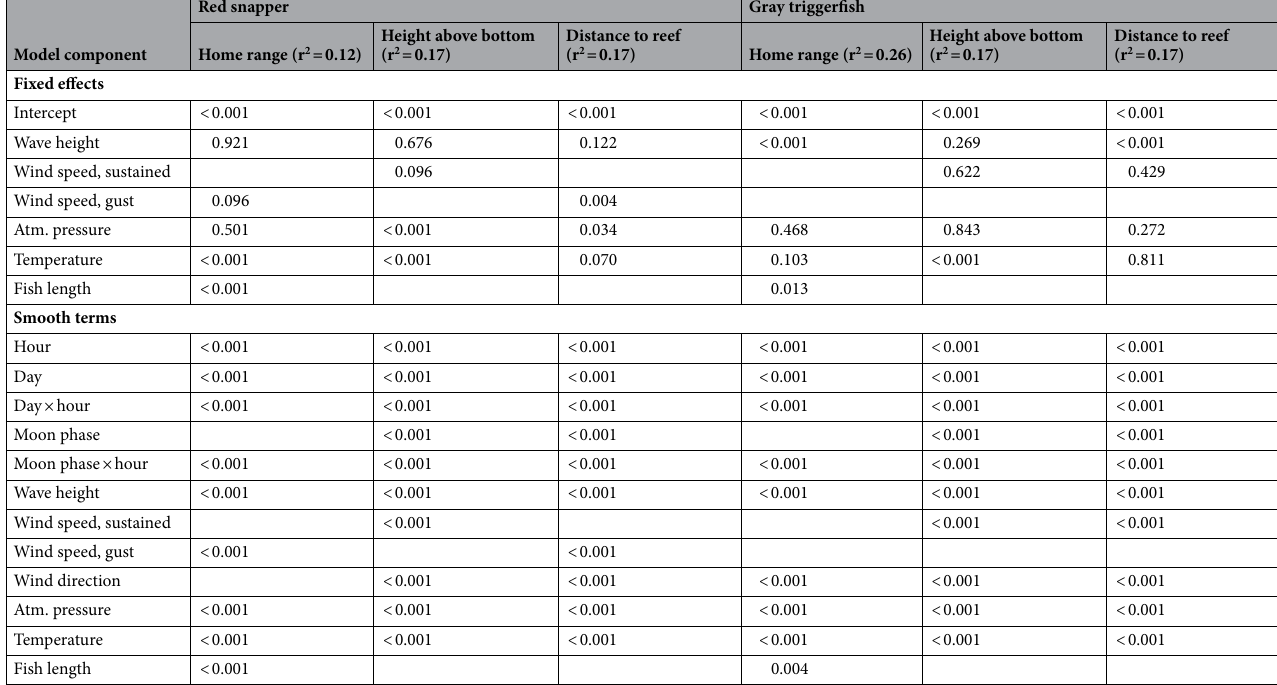
Table 1. Significance of GAMM components describing red snapper and gray triggerfish hourly 2-dimensional home range, height above bottom, and distance to reef. Random intercepts were included a priori for individual (both species) and array (red snapper only). Missing values indicate the model component was not included in the most parsimonious